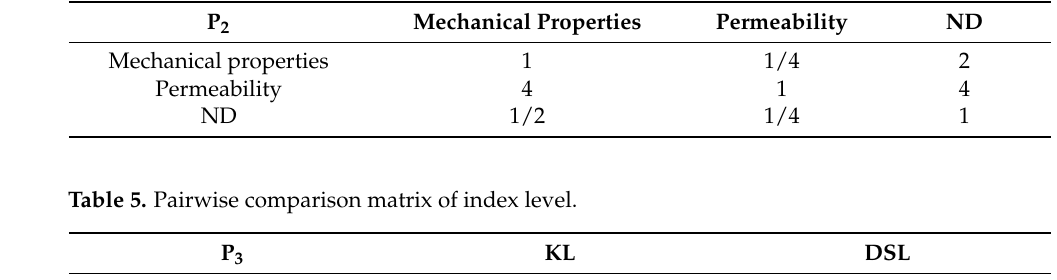
Table 4. Pairwise comparison matrix of criterion level.